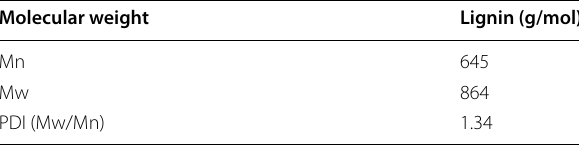
Table 5 Molecular weight analysis of the lignin extracted from palm